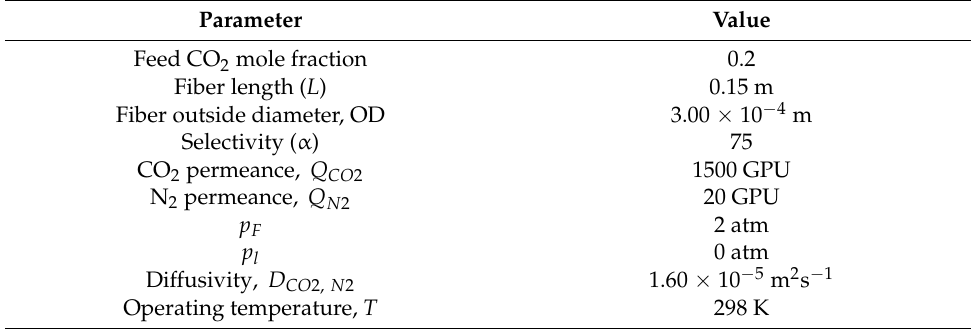
Table 3. Module properties and operation